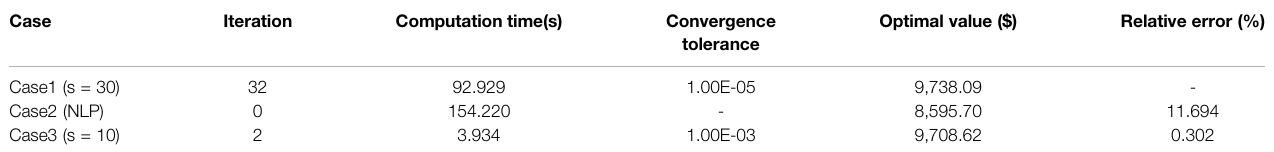
TABLE 2 | Optimization result comparison for different cases.